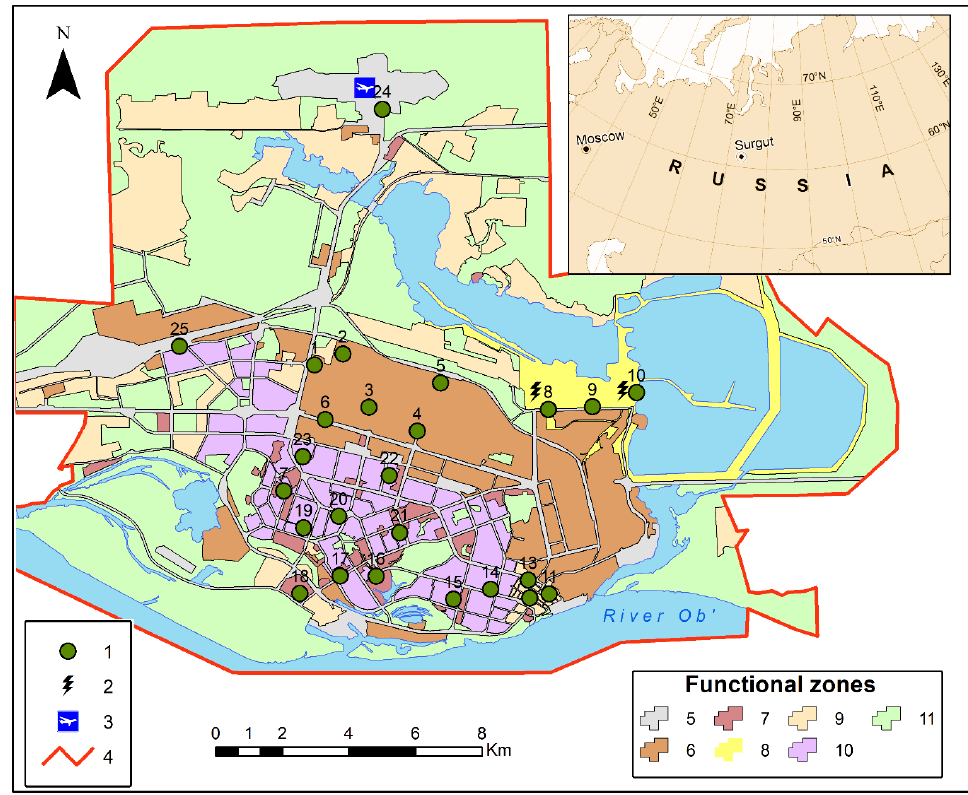
Figure 1. Sampling sites and land use areas within the city of Surgut: 1—sampling sites; 2—power plants; 3—airport; 4—city border; 5—transport area; 6—industrial and warehouse area; 7—public and business area; 8—power plant area; 9—low-rise area; 10—high-rise residential area; 11—recreation area, urban forests, green